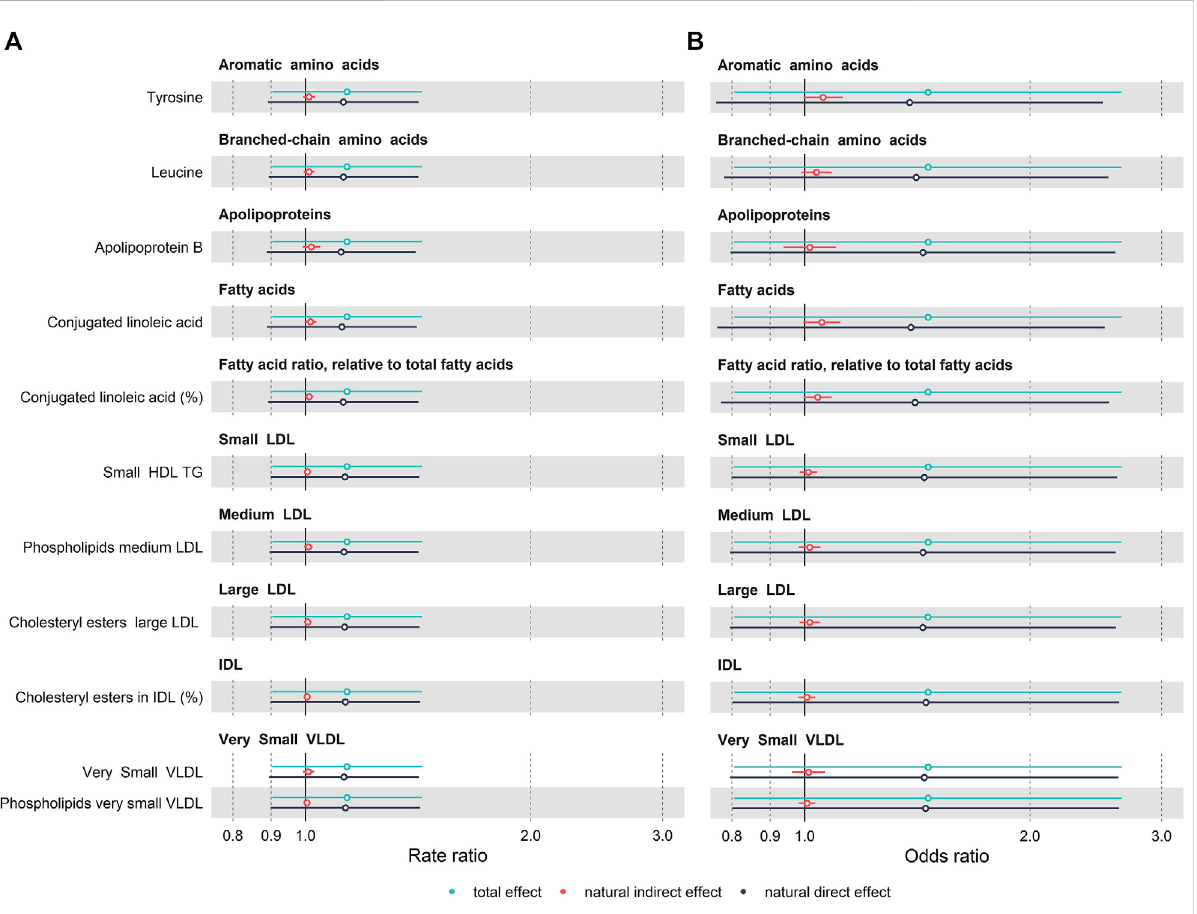
FIGURE 4 Forest plot of mediation analysis for mood related outcomes, (A) SMFQ score and (B) depressive symptoms (SMFQ score > 7), across 11 metabolic compounds. Models are adjusted for sex and age of child, physical activity at the age of 5 years, age of mother at birth,